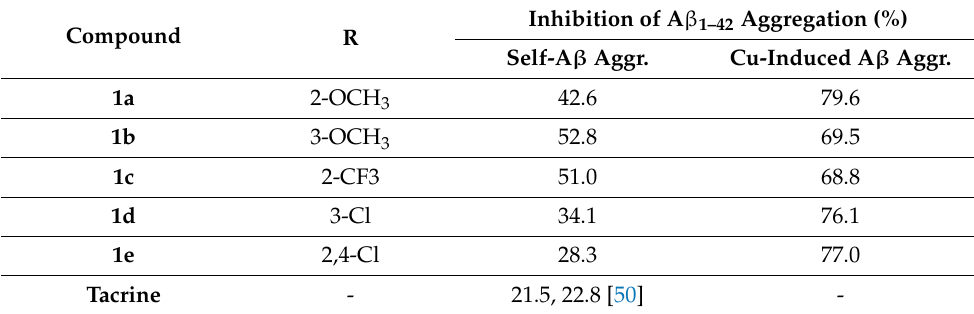
Table 3. Inhibitory capacity of the compounds for A β 1–42 aggregation *. Compound